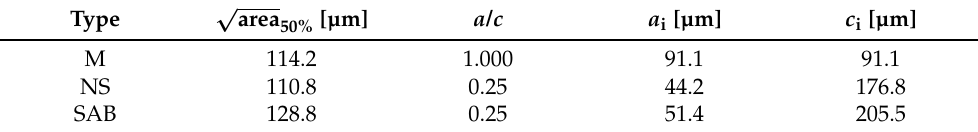
Table 7. Defect parameters adopted for the FCG simulations supposing an initial semi-elliptical crack.